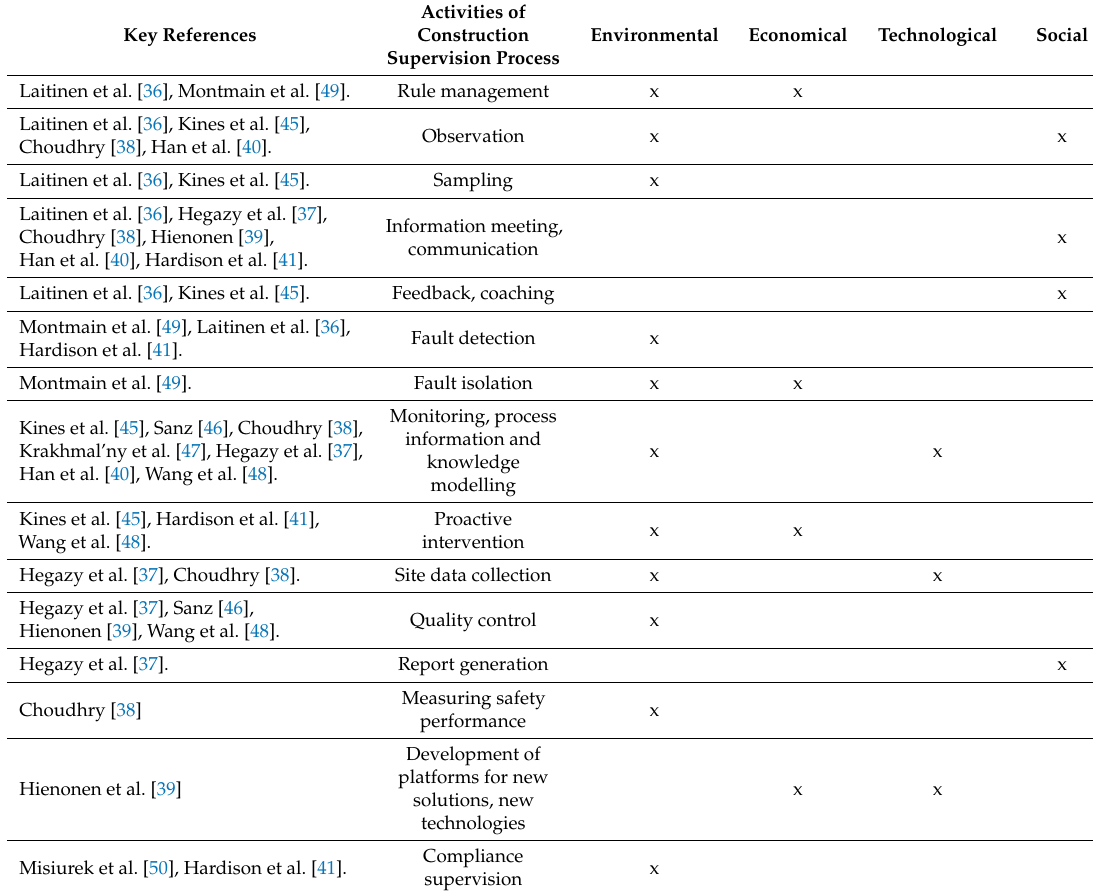
Table 1. The activities of the construction supervision